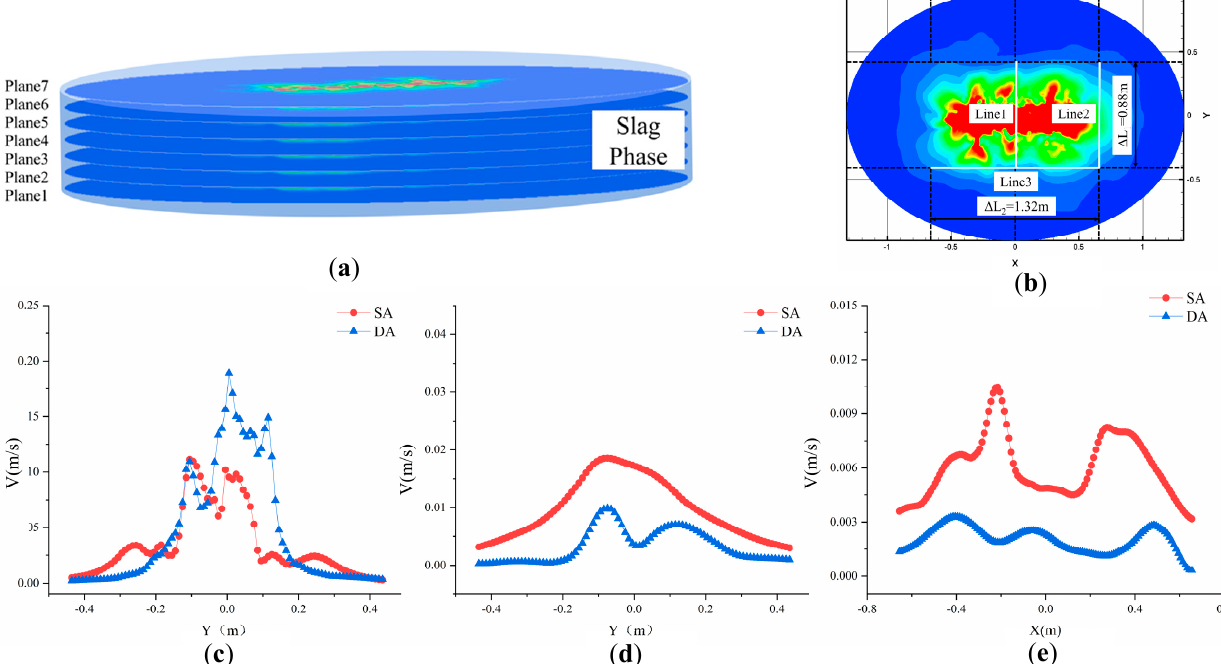
Figure 8. Data extraction location and velocity distribution of the three sampling lines: ( a ) Selection of sampling planes; ( b ) Selection of sampling lines; ( c ) Velocity distribution on Line 1; ( d ) Velocity distribution on Line 2; ( e ) Velocity distribution on Line 3.